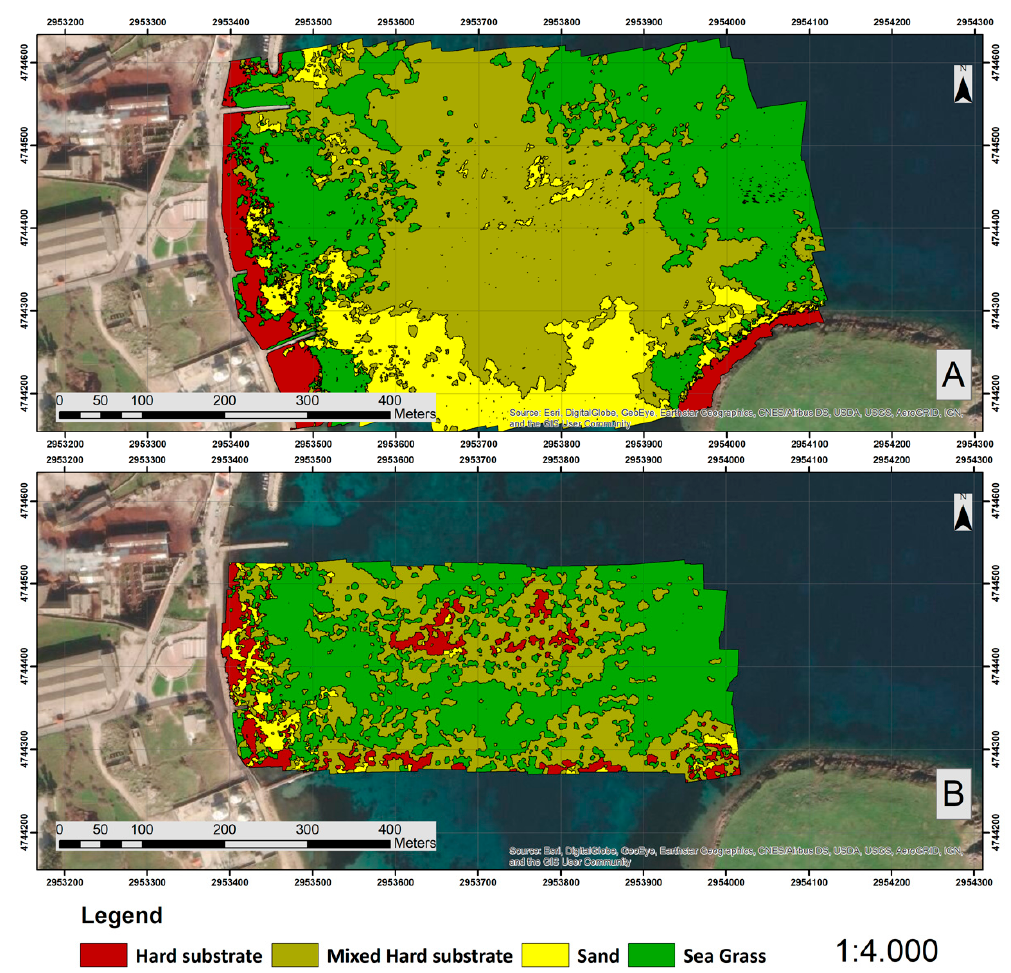
Figure 8. Classified maps for k-nearest neighbor as the classifier for the study area: ( A ) true-color RGB orthomosaic map and ( B ) multispectral orthomosaic map. Table 4. Accuracy matrix for the true-color RGB (tc-RGB) orthomosaic, with k-nearest neighbor as the classifier. KIA: Kappa index of agreement.